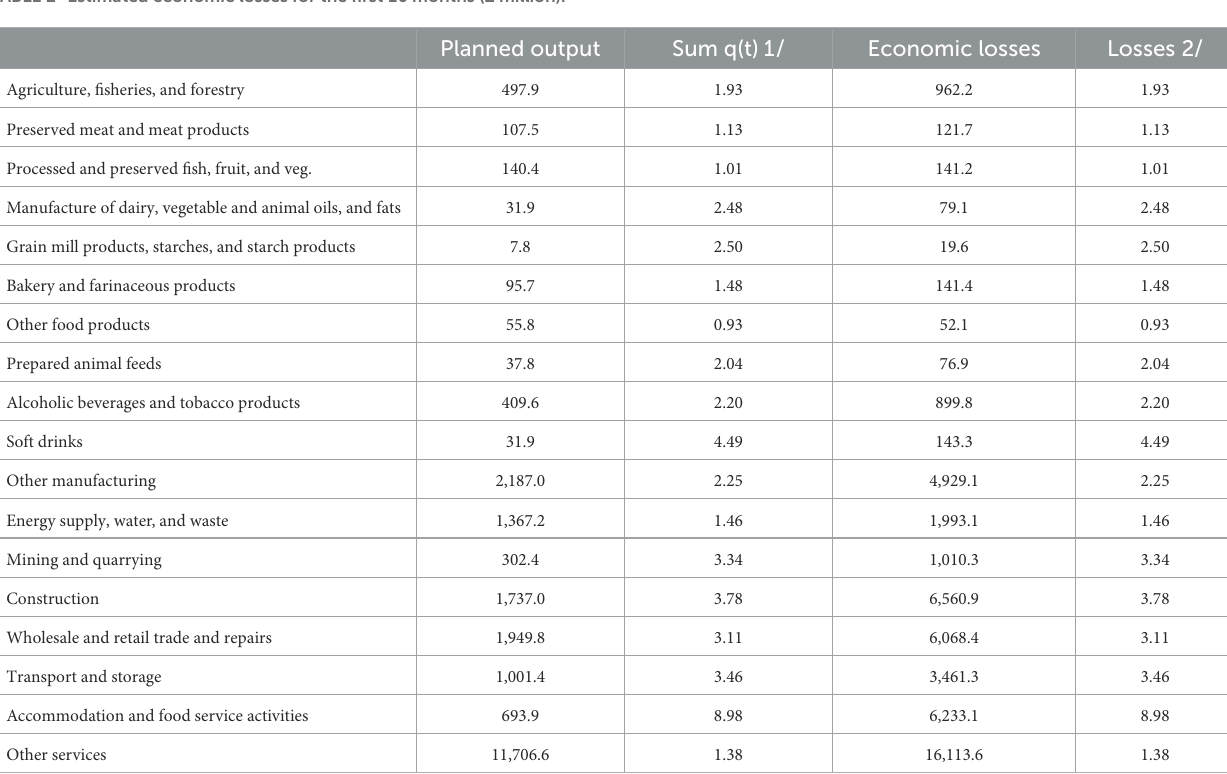
TABLE 2 Estimated economic losses for the first 10 months (£